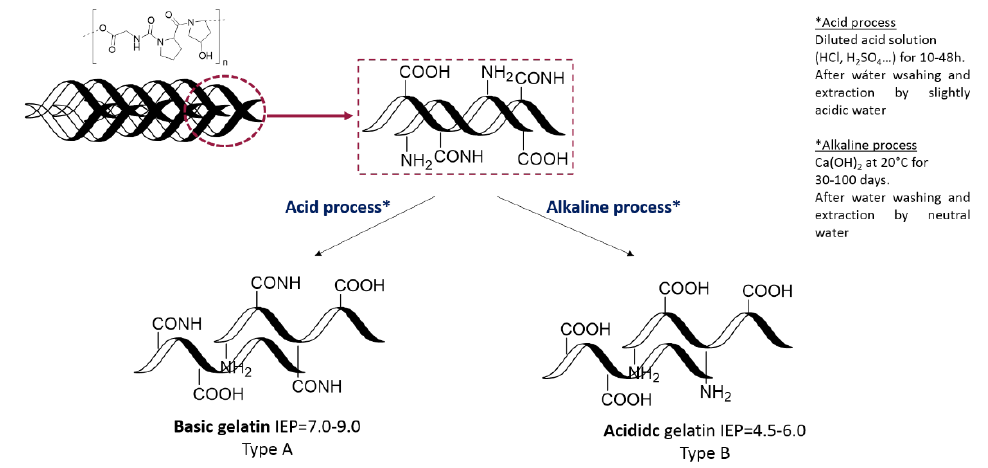
Figure 8. Collagen processing method for yielding gelatin samples with different IEP values.